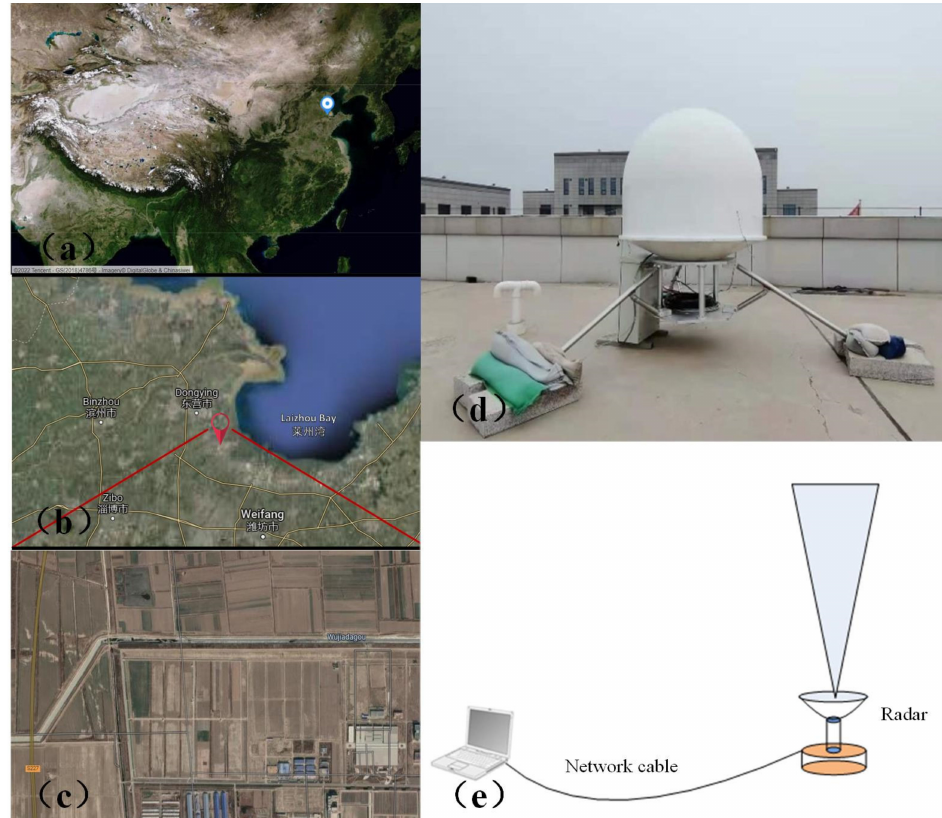
Figure 1. Schematic of the experimental monitoring test setup for migratory insects: ( a ) radar site location (Dongying, Shandong, China. Review number: GS(2018)4786). ( b ) Magnified radar site location. ( c ) Schematic diagram of the radar observation area. ( d ) The Ku-band fully polarimetric entomological radar. ( e ) Vertical observation. (The Chinese in the figure means the name of location).